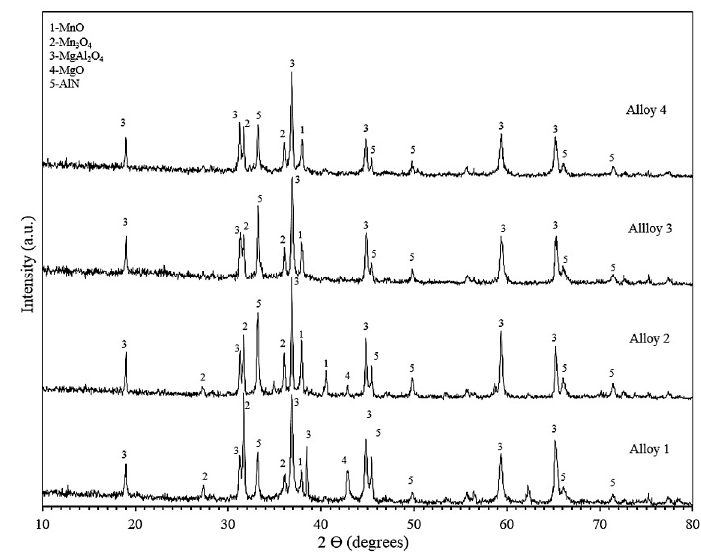
Figure 2. X-ray diffraction (XRD) pattern of the slags obtained from experiments at constant temperature and constant agitation of the molten bath, for alloys with different initial concentrations of Mg.